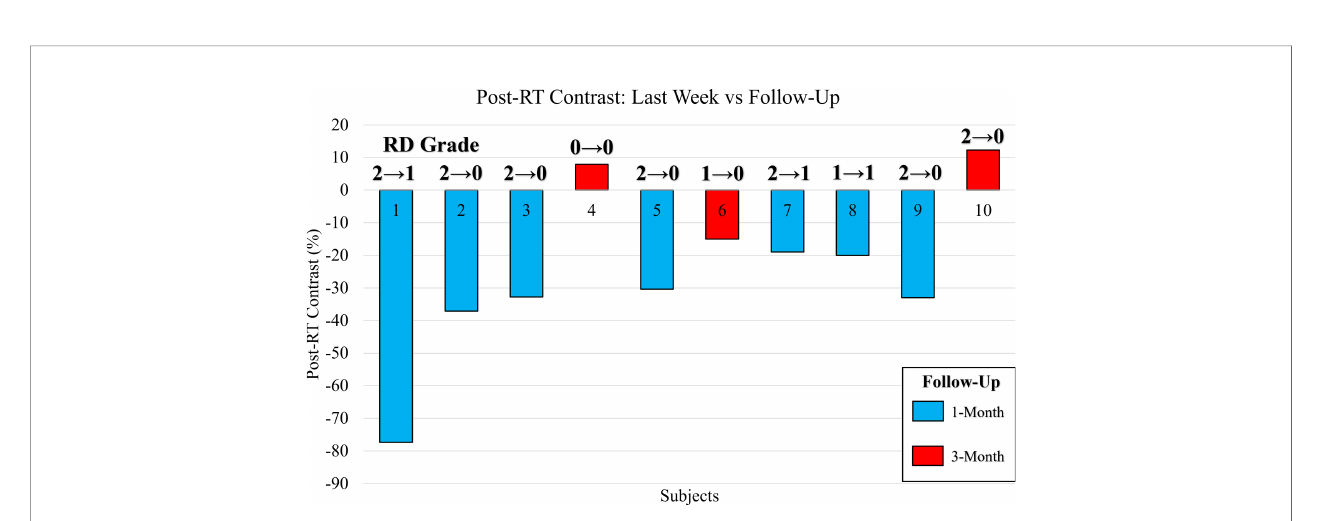
FIGURE 7 | Bar plot of the post-RT StO 2 contrast between the last week of RT and follow-up assessment. Contrast reported as a percentage change of the follow- up assessment with respect to the last week of RT. Bars color coded to indicate patients assessed at 1-month (blue) and 3-months (red). The CTCAE RD grading as provided by clinician is included for the last week of RT and during the follow-up assessment (RD Last Week ! RD FU ).